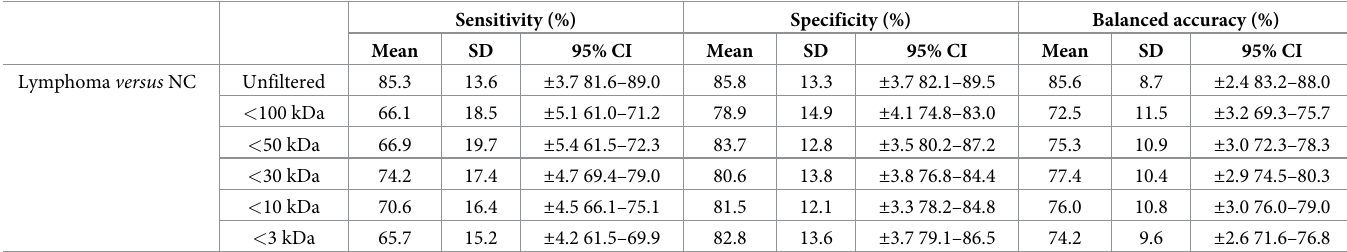
Table 2. Sensitivity, specificity and balanced accuracies for the PLS-DA model classification of lymphoma versus non-cancer patients. Mean, standard deviation (SD) and 95% confidence intervals (CIs) are provided. Sensitivity